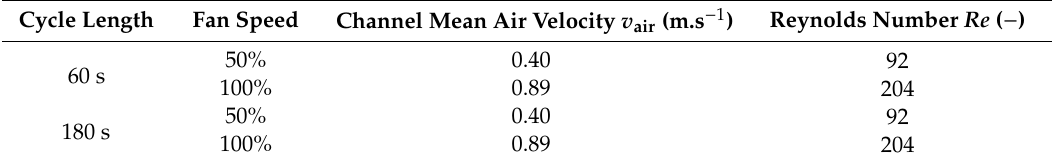
Table 2. List of parametric values. The used characteristic length to calculate the Reynolds number is the hydraulic diameter 𝑑 ℎ , defined in Equation (15).